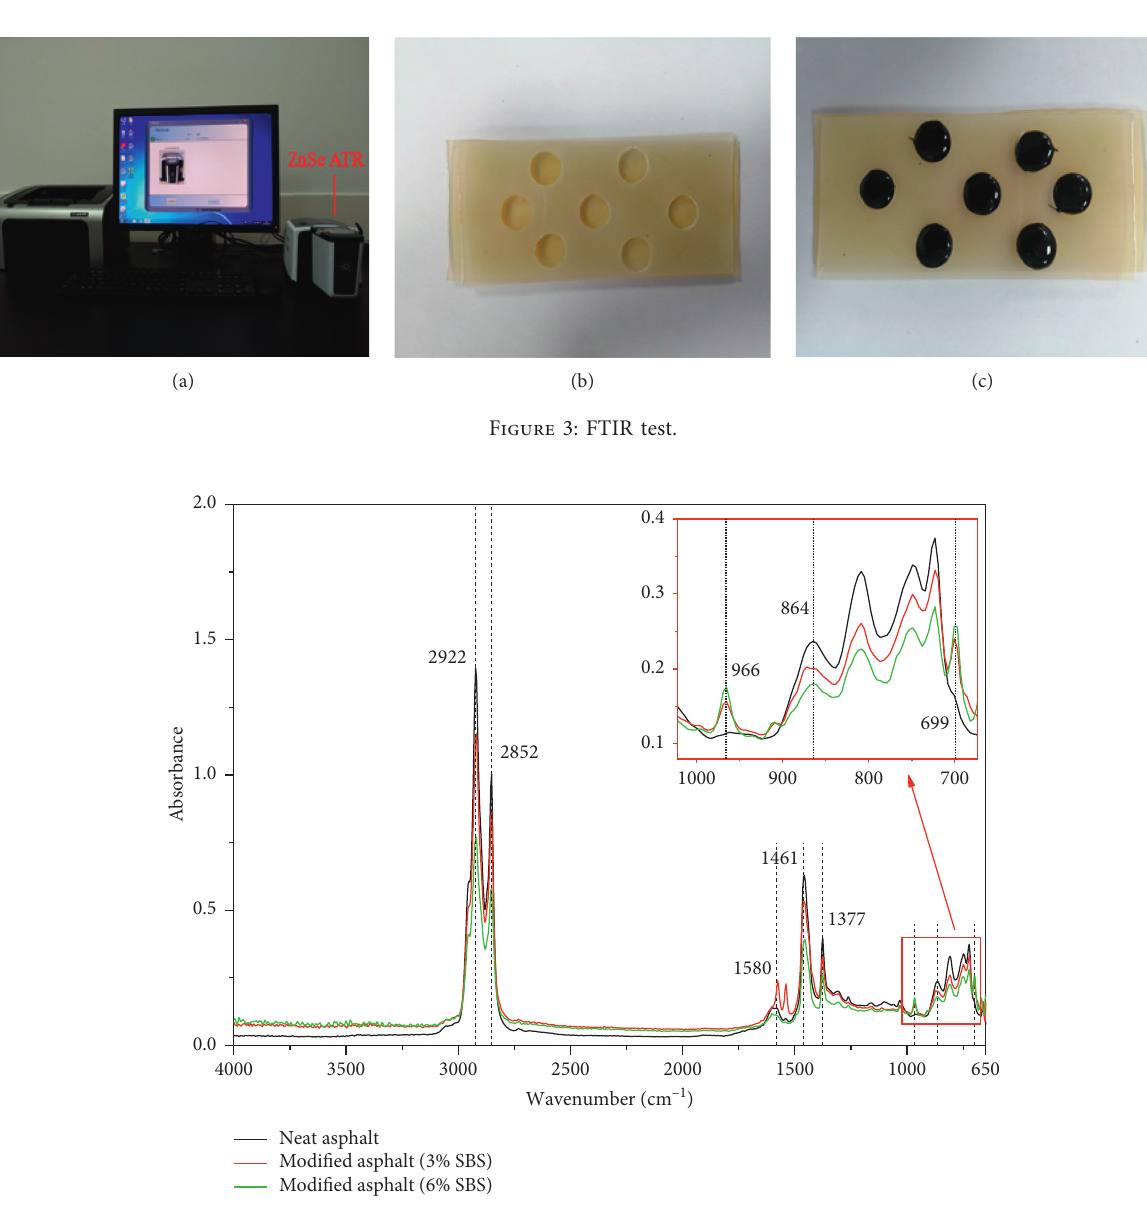
Figure 4: FTIR spectra of neat and SBS modified